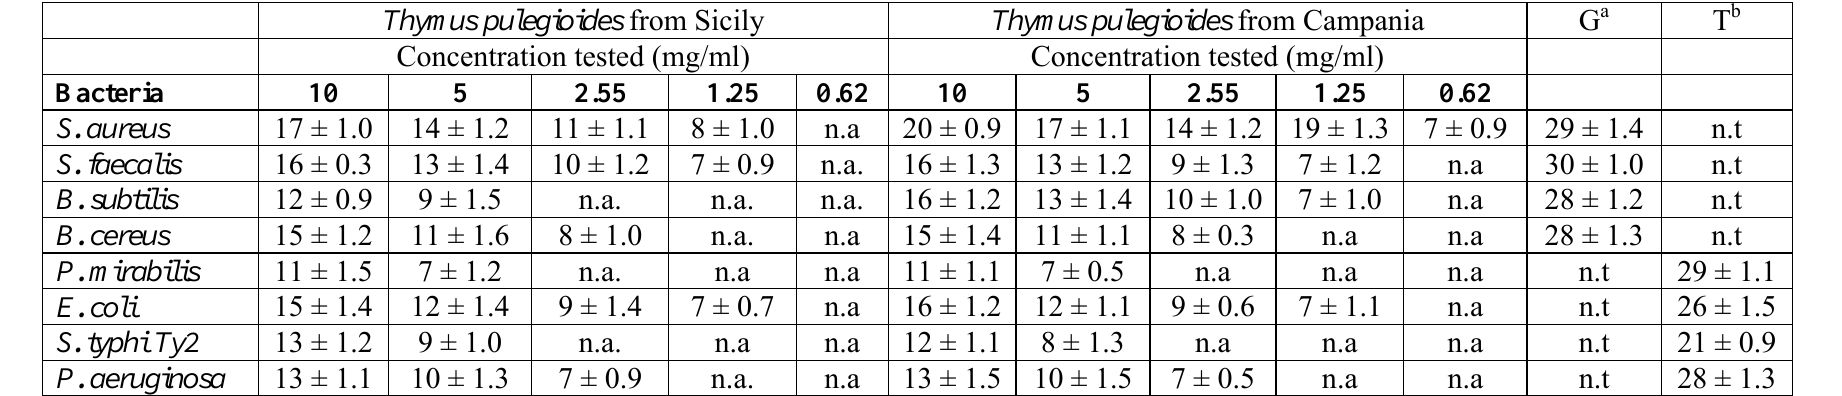
Table 2b. Antibacterial activity (diffusion method) of different amounts of the essential oil of T. pulegioides . Inhibition is expressed in mm and include the diameter of paper disc (6 mm). Results are shown as mean ± standard deviation (SD) of the inhibition zone (n =